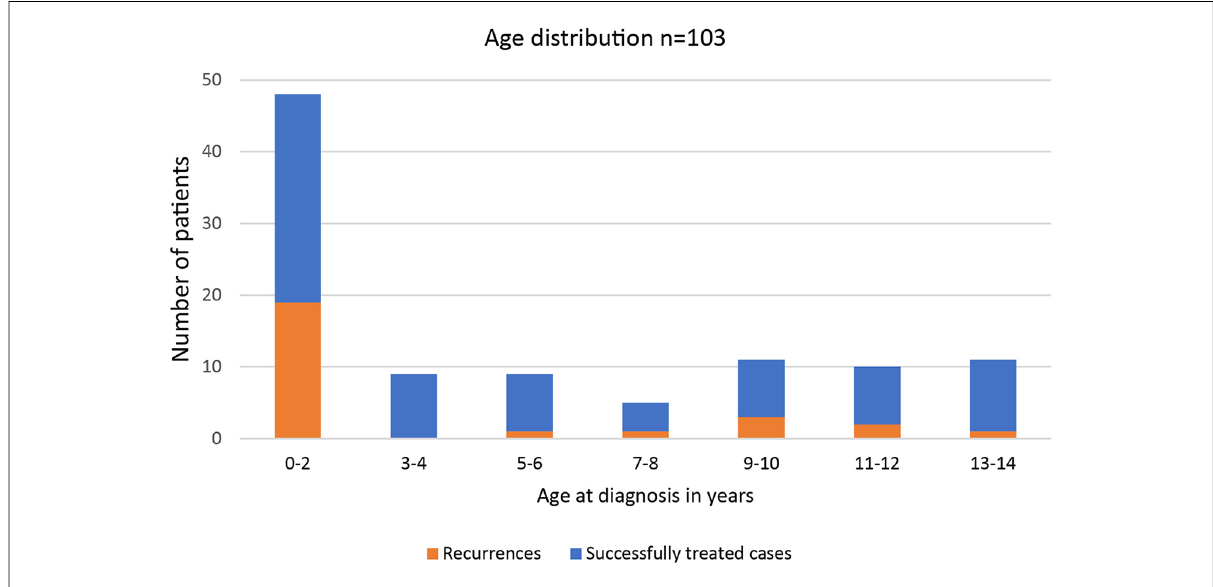
FIGURE 1 Distribution of incidence and outcome by age of onset of perianal